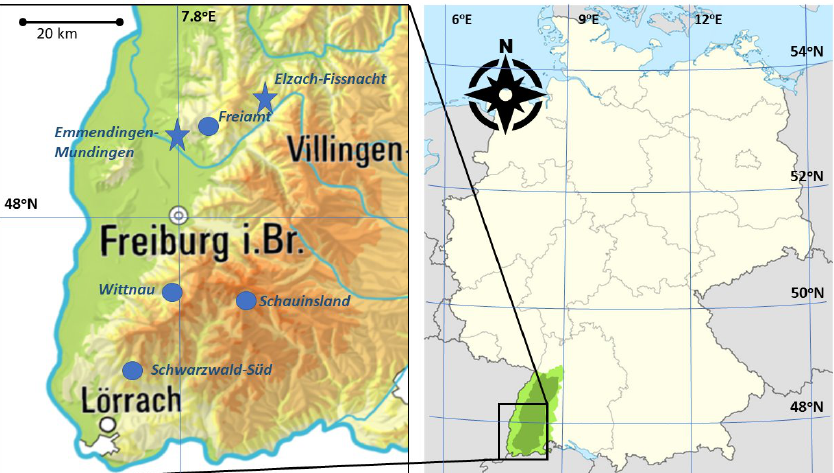
Figure 2. The location of the Black Forest within Germany ( right ) and the area of investigation with locations of the experimental forest sites (Freiamt), as well as observation stations for meteorology (stars), air pollution (Schauinsland, Schwarzwald-Süd), and albedo (Wittnau) (sources: Landesamt für Geoinformation und Landentwicklung Baden Württemberg, www.lgl-bw.de ( left ) and wikimedia commons ( right ), with added longitude and latitude).